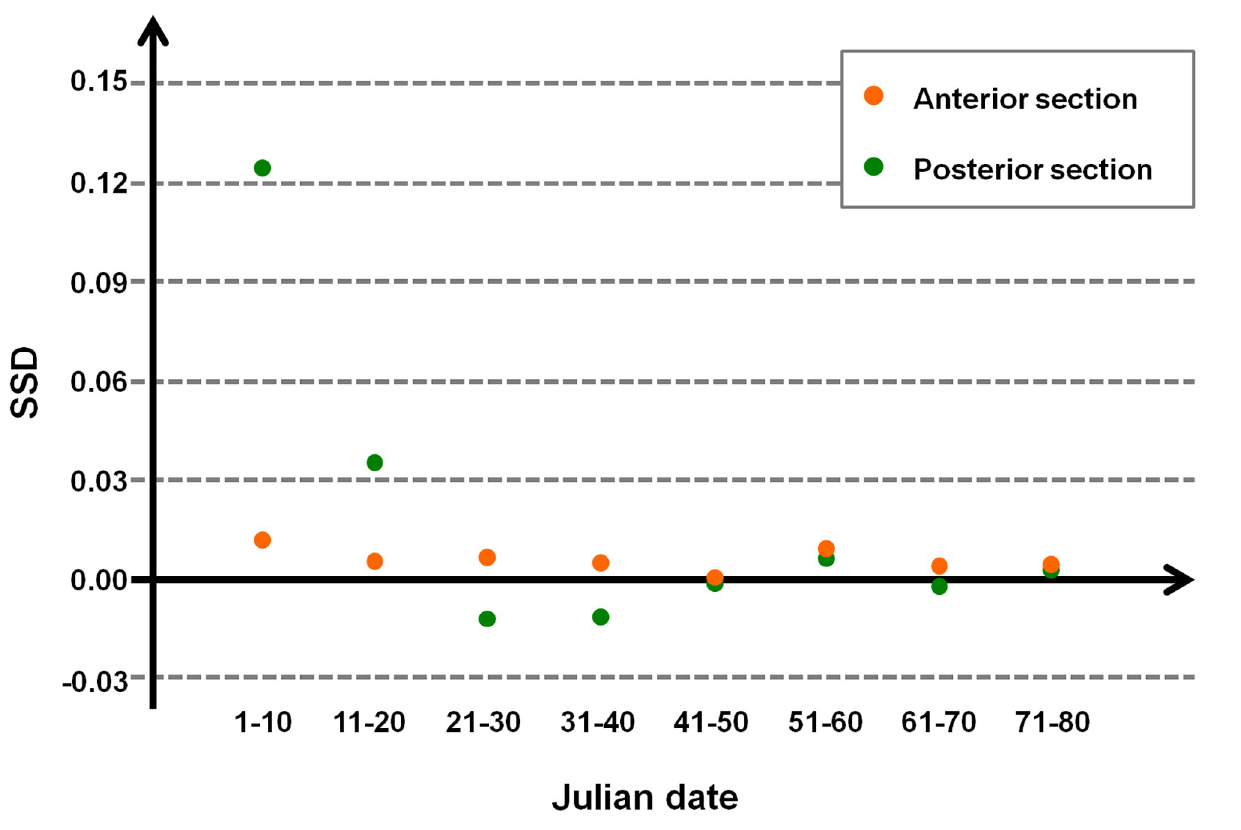
Fig 4. Sexual size dimorphism (SSD). SSD in the length of the anterior and posterior section of 2,161 mandibles of juveniles (8–10 months; 1,176 females and 985 males), collected during the 2013–2015 hunting seasons in the Arezzo province (Tuscany, Central Italy), in relation to the Julian date (1 st January-15 th